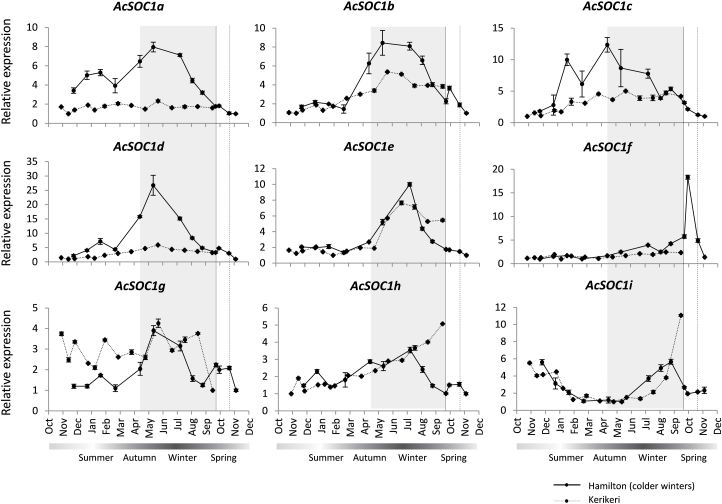
Relative expression of kiwifruit SOC1-like genes in axillary buds during the growth and dormancy cycles, normalized to kiwifruit UBC9 and expressed as a ratio to the sample point with lowest expression, which was arbitrarily set to 1. Data points represent the mean ±SE for two replicates, the solid line represents samples collected from Hamilton, New Zealand, in 1995–1996, and the dotted line represents samples collected from Kerikeri, New Zealand, in 2008–2009. The vertical solid and dashed lines indicate budbreak time in Hamilton and Kerikeri, respectively. Hamilton is the region with colder winters (Supplementary Fig. S2 at JXB online).